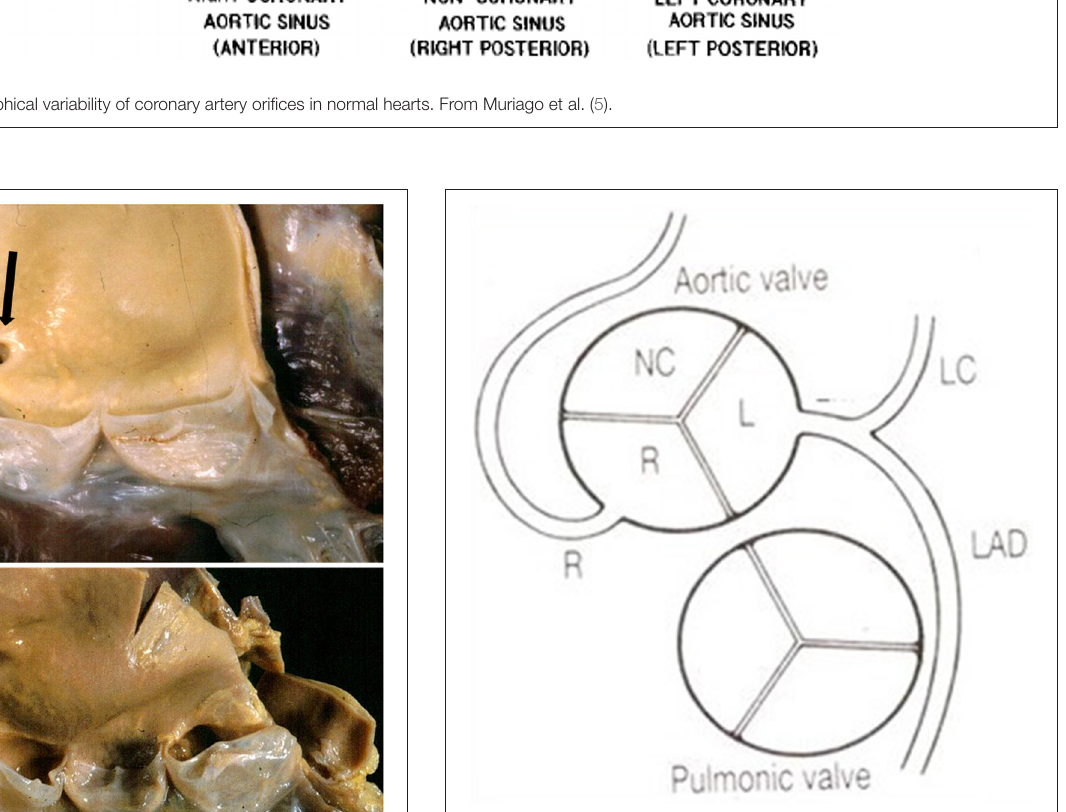
FIGURE 5 | The coronary arteries arise from the facing aortic sinuses, perpendicular to the aortic wall, and the pulmonary root does not interfere with their proximal course. Note the left stem dividing into the left anterior descending (LAD) and the left circumflex (LC) branches. From Roberts (6). According to Baroldi (3), a right dominant pattern is present in 79% of cases, left dominant in 7% and balanced in 14%. In the apex and runs in the posterior interventricular groove,